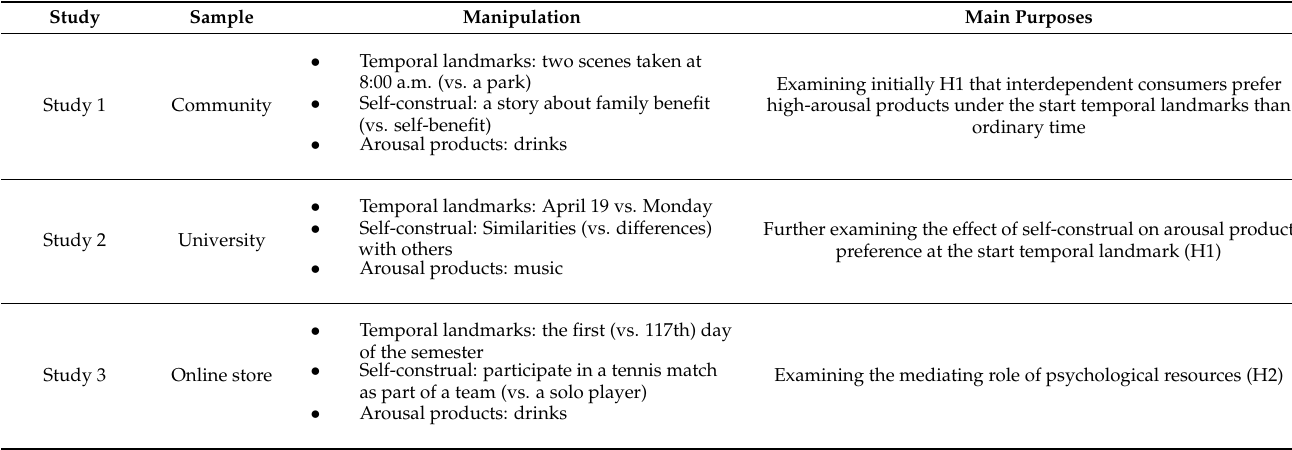
Table 1. Overview of